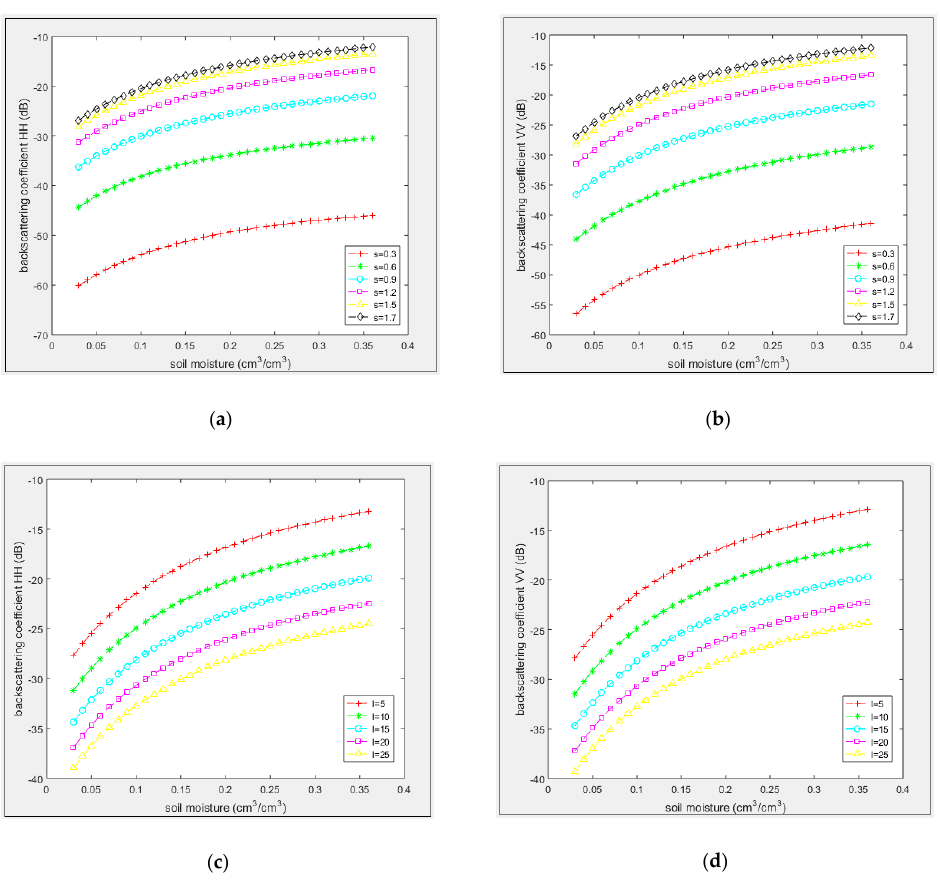
Figure 8. Responses of the soil moisture and soil backscattering coefficient: ( a )( c ) HH polarization; ( b )( d ) VV polarization.